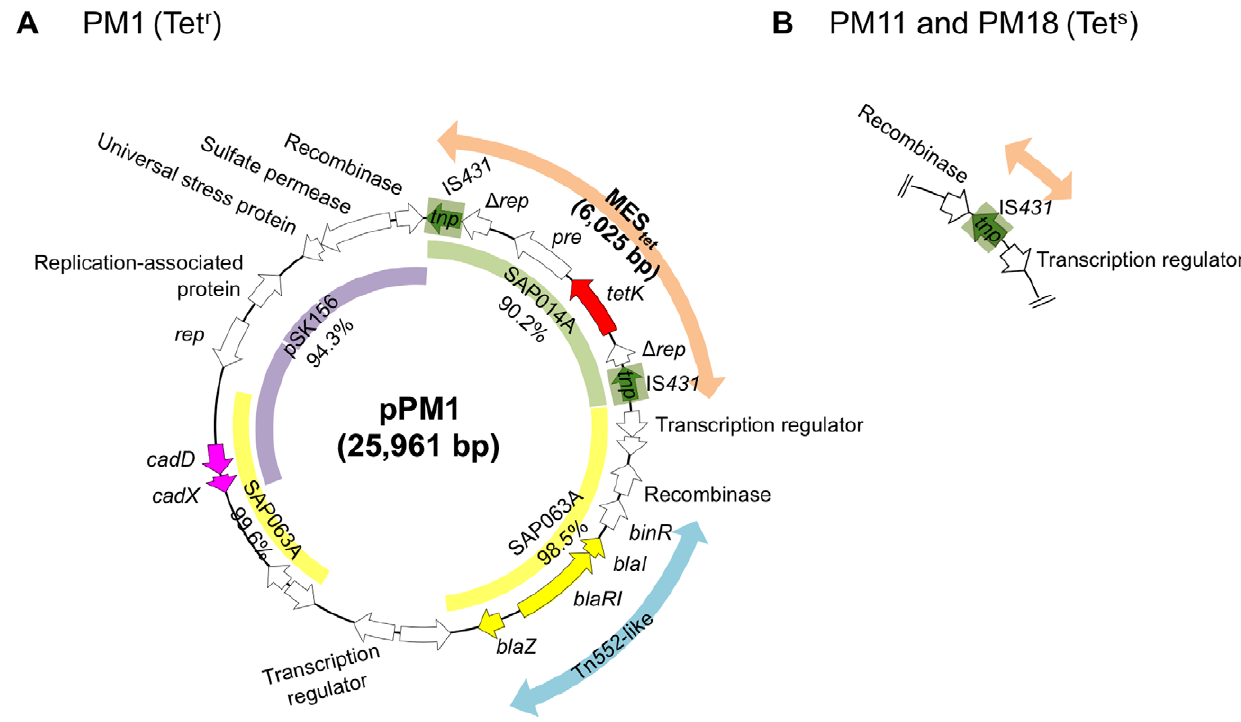
Figure 4. Genetic structure of penicillinase plasmid pPM1 and its segregant. In A, pPM1 structure is shown. Inner circle indicates homologous regions to S. aureus plasmid SAP014A (GenBank accession number GQ900379), SAP063A (GenBank accession number GQ900418), and pSK156 (GenBank accession number GQ900448). The IS 431 region with the transposase gene ( tnp ) is shaded in light green. A Greek delta symbol indicates truncated coding sequence. In B, a segregant of pPM1 in MES tet locus is shown. Tet r , tetracycline-resistant; Tet s ,